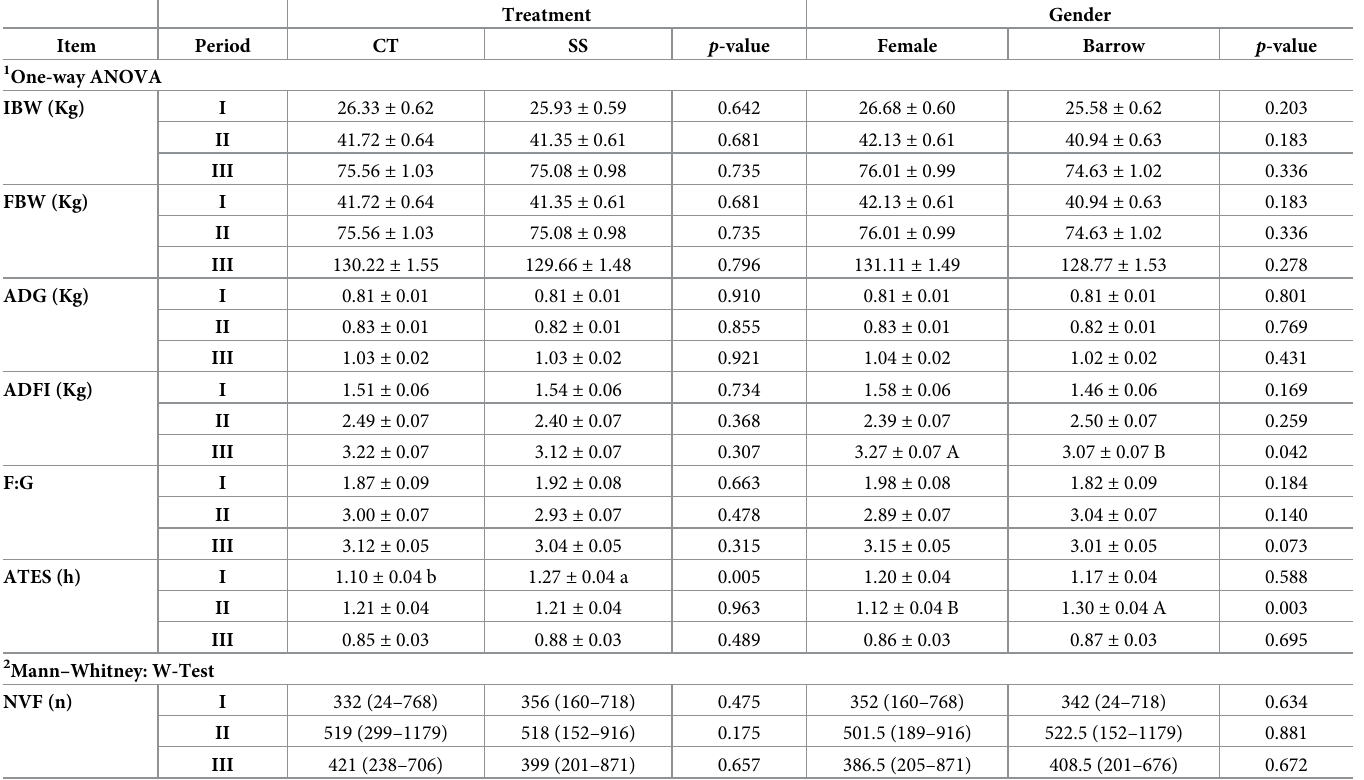
Table 3. Data of performance (mean ± SE) and feeding behavior (median, min—max) of growing and finishing pigs according to treatment, gender, and period of mixing. Treatment